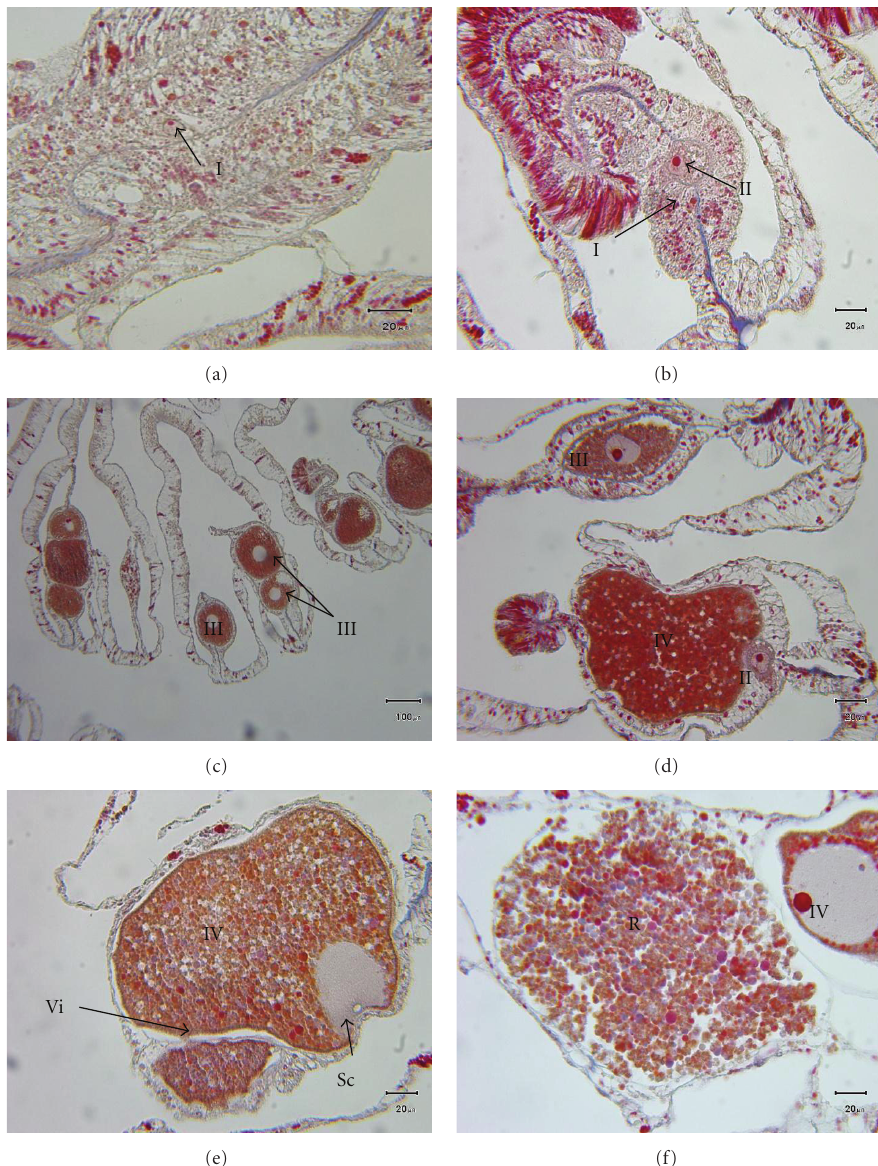
Figure 2: Photomicrographs of Solenastrea bournoni oocyte stages I–IV (defined by Table 1). (a) Stage I oocyte; (b) stages I and II oocytes; (c) stage III oocytes; (d) stages II, III and IV; (e) stage IV oocytes, Vi = vitelline membrane, Sc = scalloping of nucleus; (f) stage IV oocyte adjacent to oocyte resorption (R). All scale bars 20 μ m except for (c) which is 100 μ m.